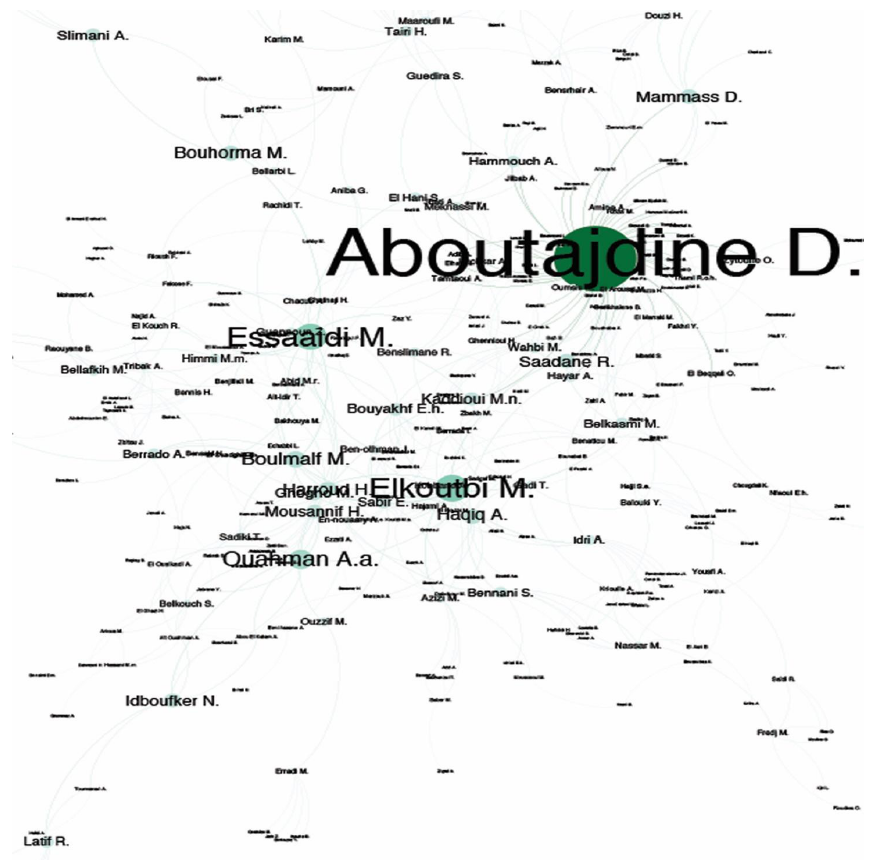
Fig. 2. Mapping of scientific collaboration between Moroccan authors in "computer Science" from 2007 to